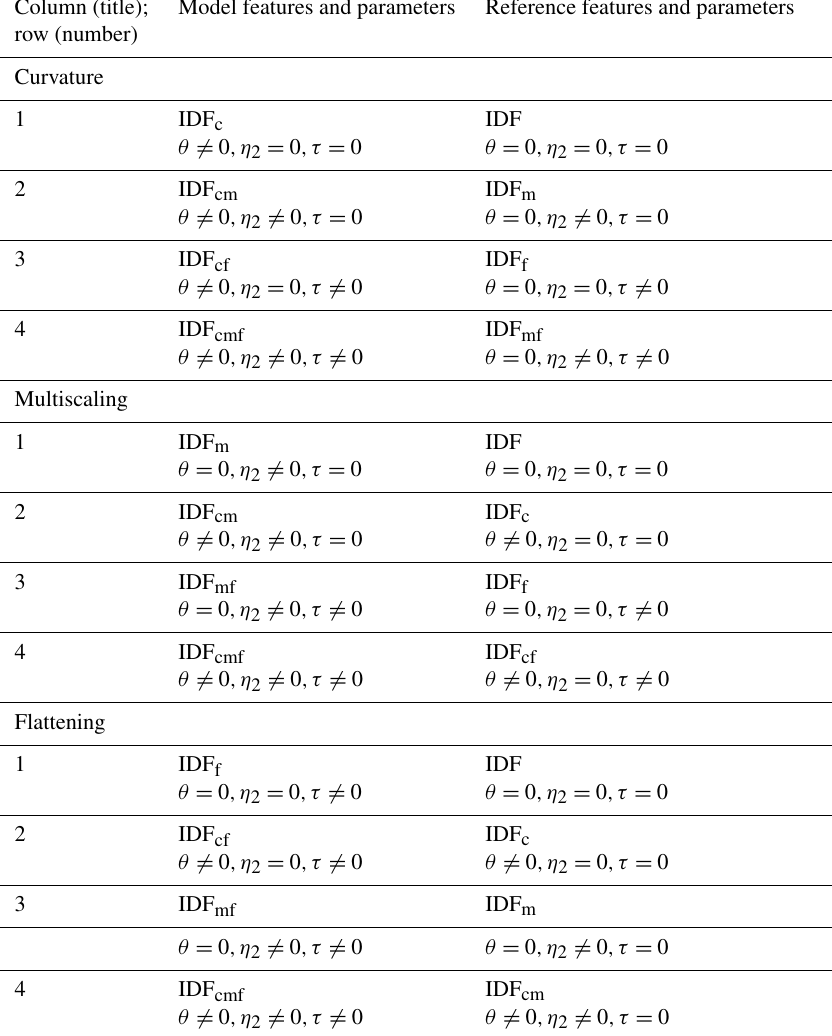
Table E1. Overview of models and references for verification. Column (title); Model features and parameters Reference features and